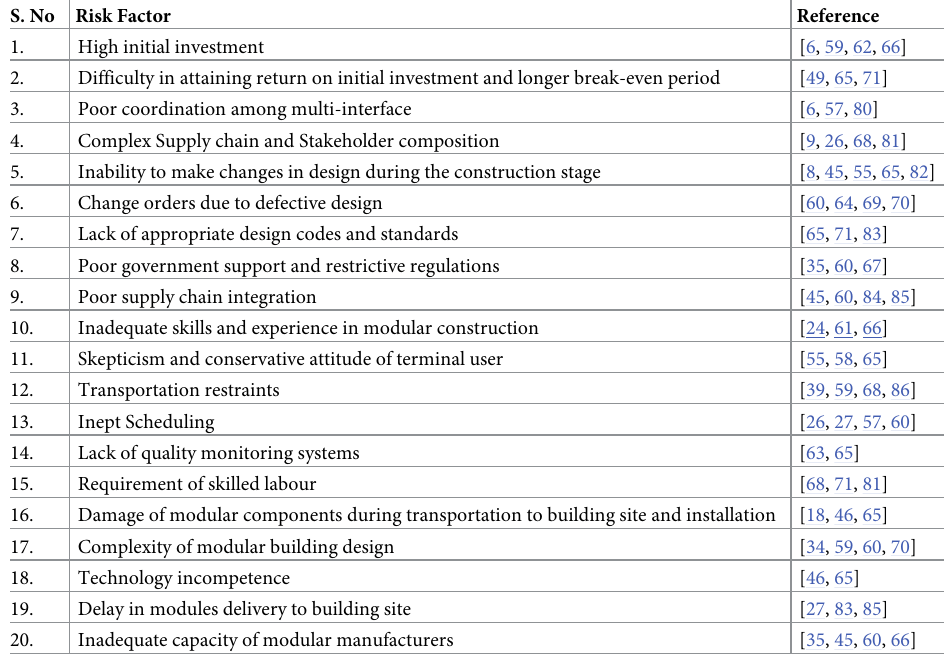
Table 1. Critical risks associated with the implementation of modular